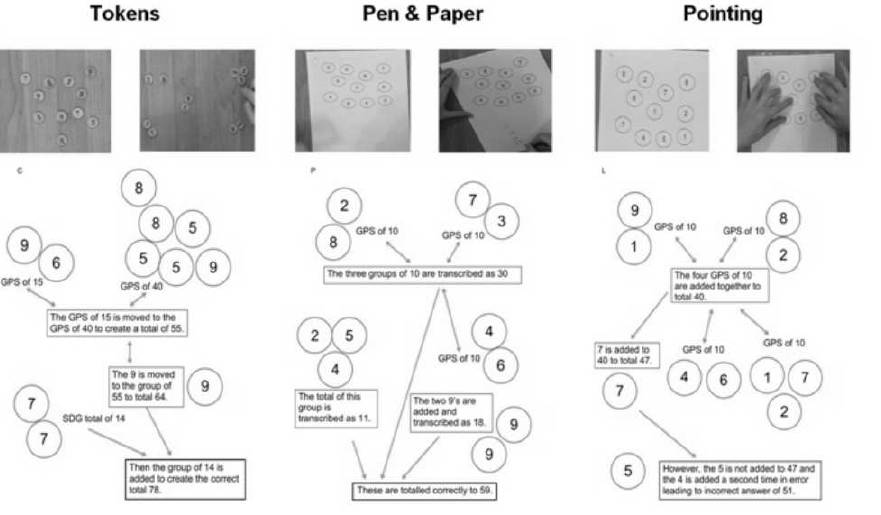
Figure 3. The three panels show the stages of progress as the participant solves simple math problems in varying conditions of interactivity. The first screen shot in each of the three panels shows the initial problem presentation. The second screen shot captures the participant part way through the path to solution. The bottom image is a reconstruction of the final stages of the problem-solving process as revealed in frame-by- frame analysis of the participant’s